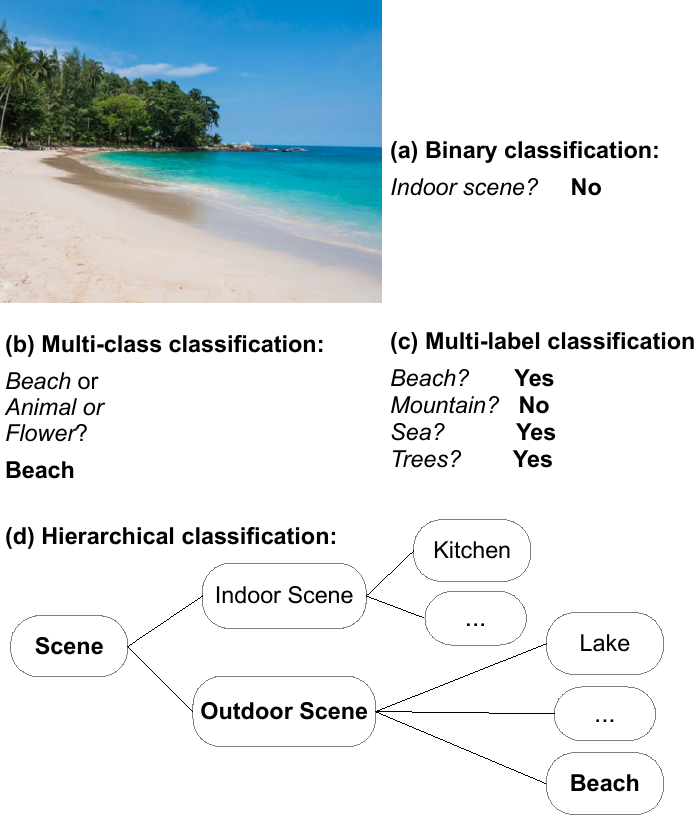
Figure A1. An illustration of classification tasks in machine